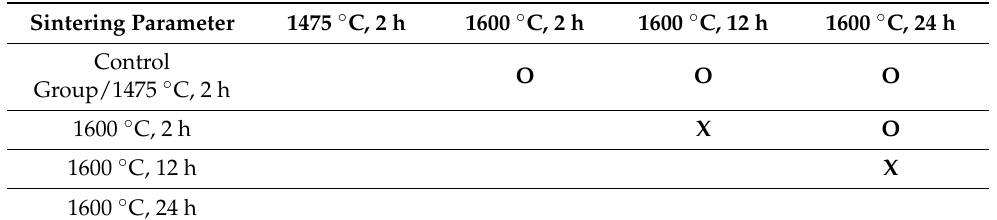
Table 3. Comparative statistical analysis (Tukey test/ANOVA) of flexural strength of Y-TZP ceramics. Sintering